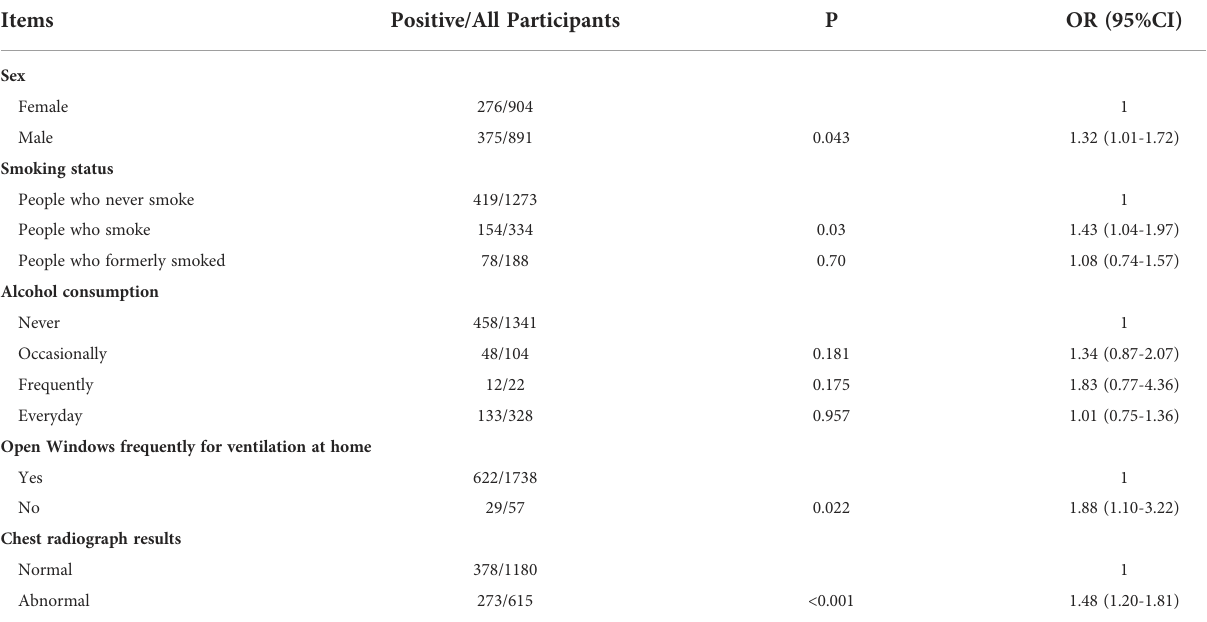
TABLE 3 Factors associated with latent tuberculosis infection among the elderly in rural area, Zhejiang, China.